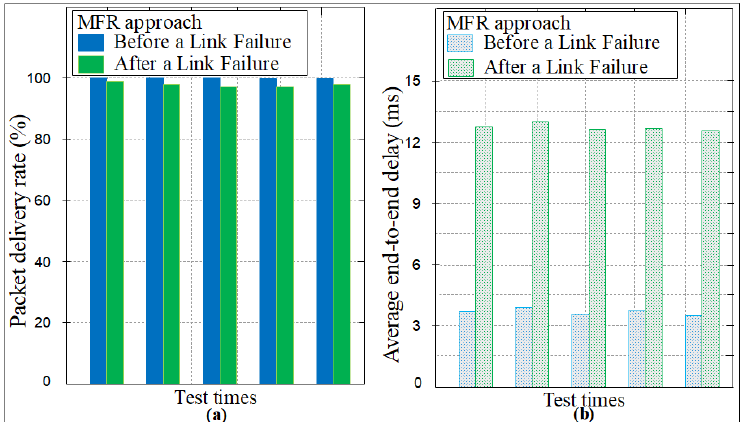
Figure 14. Testbed experimental measurement results. ( a ) Results of the packet delivery rate. ( b ) Results of average end-to-end